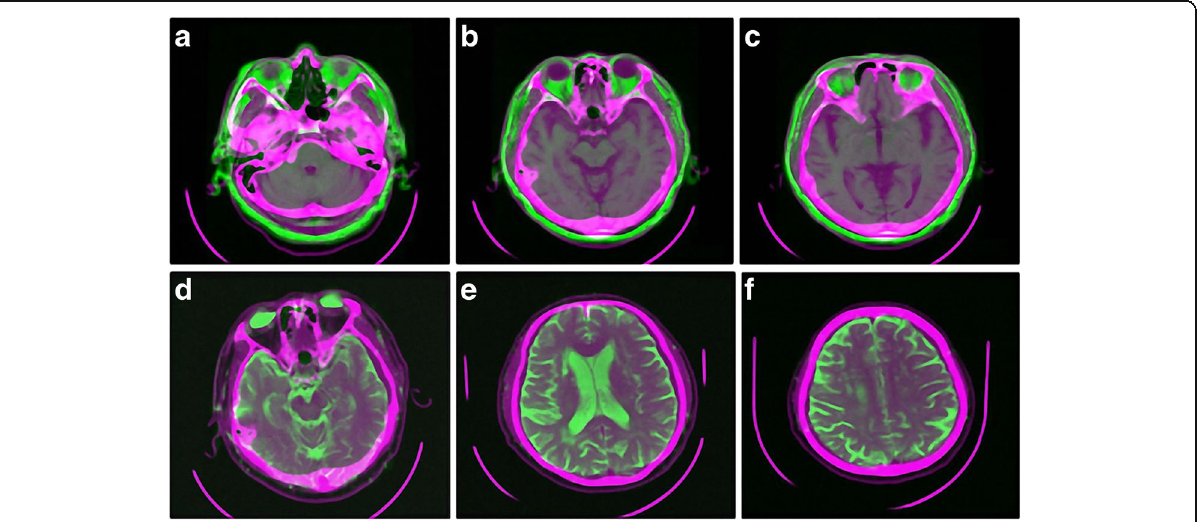
Fig. 15 The pseudo-color fusion result of patient one. a , b , c are the fusion results of CT and T1-MRI, while d , e , f are the fusion results of CT and